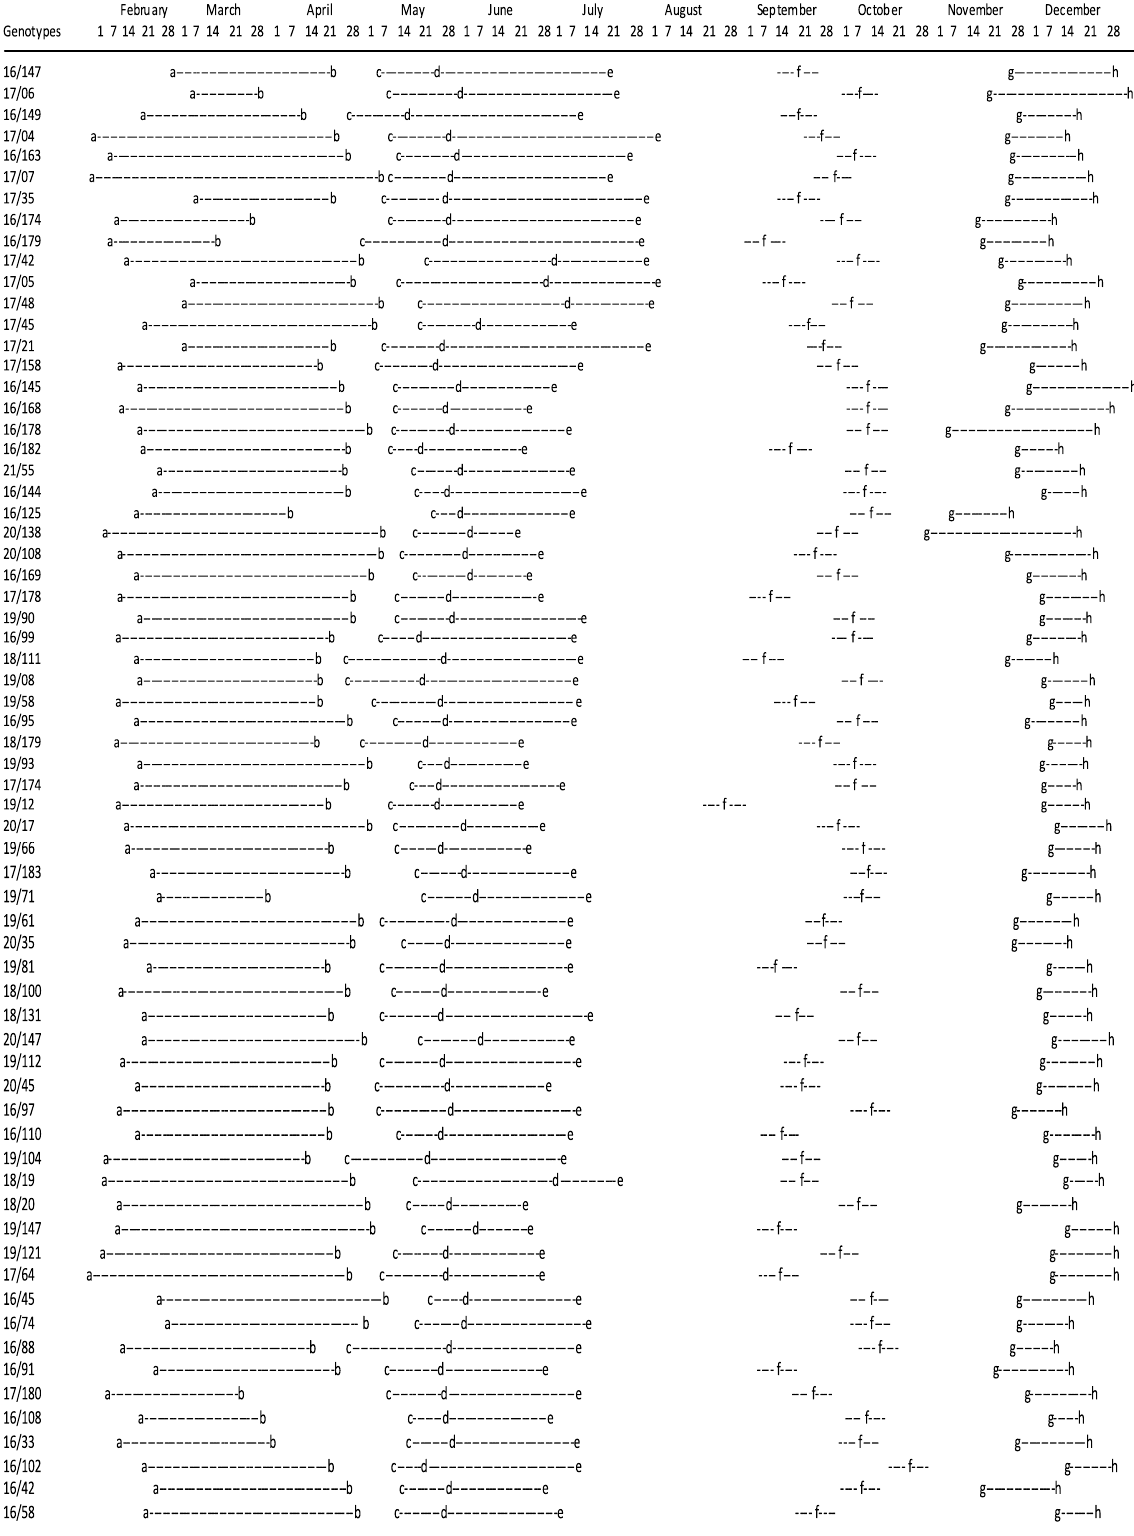
a: the break of wood buds, b: the emergence of the first flower buds, c: first blossoming, d: maximum blossoming, e: last blossoming, f: ripening, g: yellowing of leaves, h: leaves’